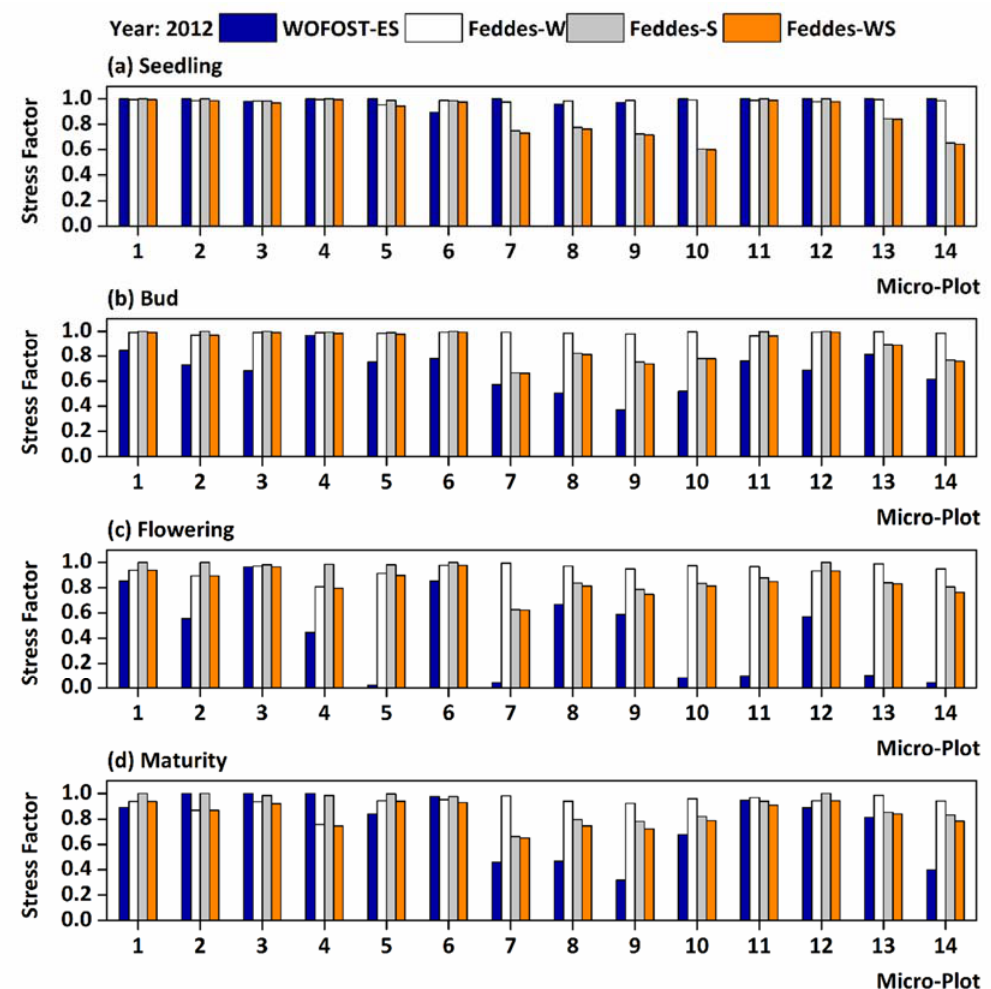
Figure 5. Environmental stress factor (ES) of the WOFOST-ES model, water stress factor of the Feddes model- α ( h ), and the salt stress factor of the Feddes model- α ( π ) for the 14 micro-plots during the seedling, bud, flowering, and maturity stages of sunflower in 2012. Sub-figures ( a ), ( b ), ( c ) and ( d ) indicate seedling, bud, flowering and maturity stages of sunflower.